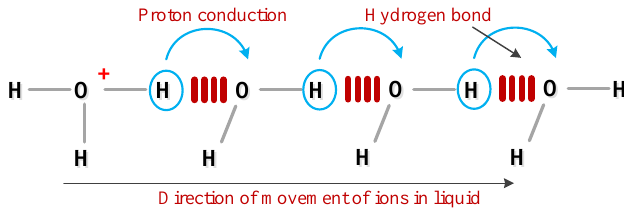
Figure 18. Proton conduction diagram of H 3 O + .